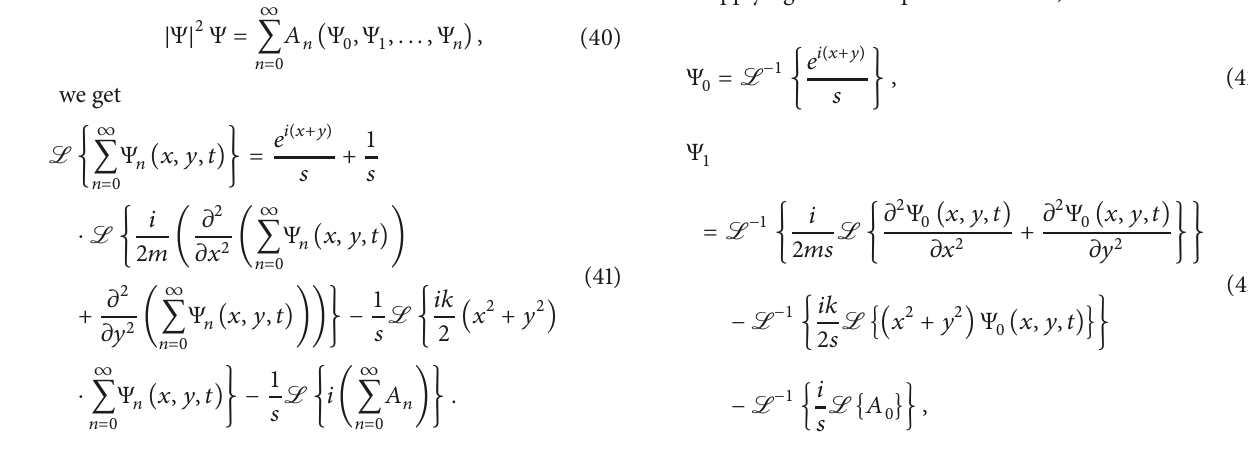
Figure 3: Imaginary solution of the one-dimensional wave function obtained by LADM and HPM.